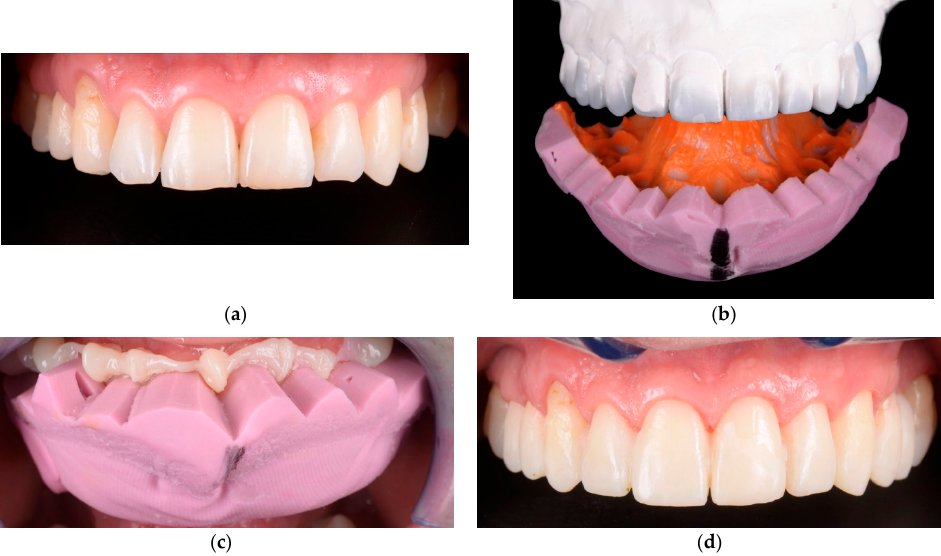
Figure 3. Direct mock-up: ( a ) initial situation; ( b ) silicon index made by diagnostic wax-up; ( c ) intraoral fabricated with a temporary resign material and silicon index; ( d ) clinical aspect of mock-up after finishing.